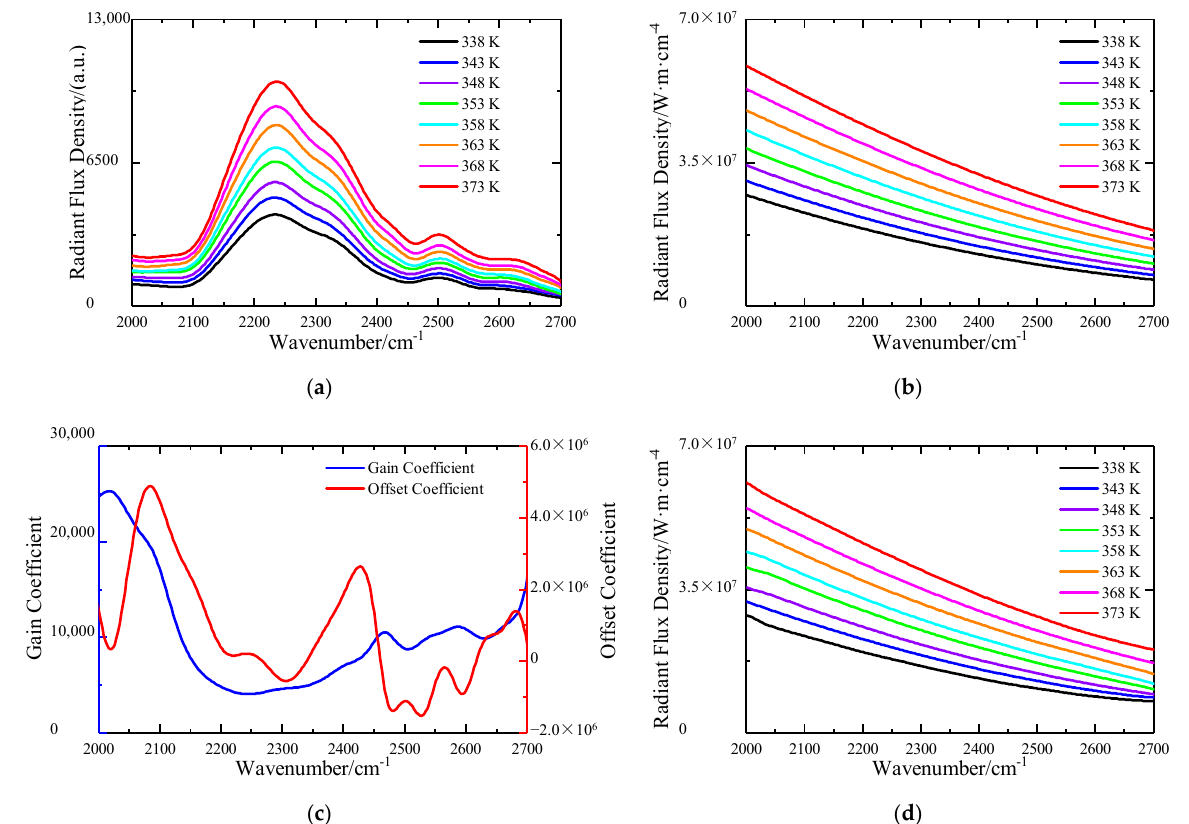
Figure 16. ( a ) Measured spectral response of blackbody at different temperatures. ( b ) Theoretical blackbody radiation. ( c ) Spectral response calibration coefficient. ( d ) Measured spectral response of blackbody after calibration.